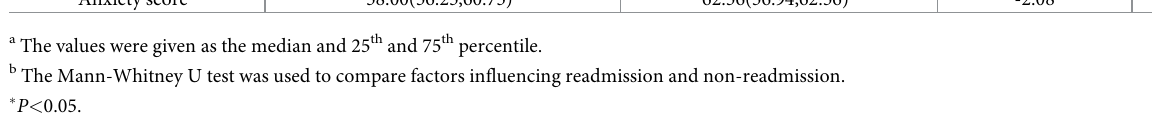
Table 10. The relationship between peri-procedure anxiety scores and readmission.